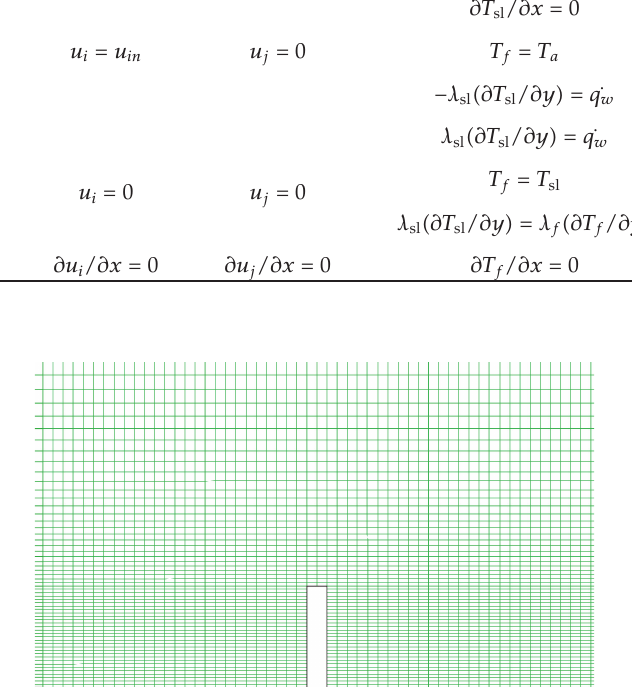
Figure 2: Scheme of the adopted mesh into the